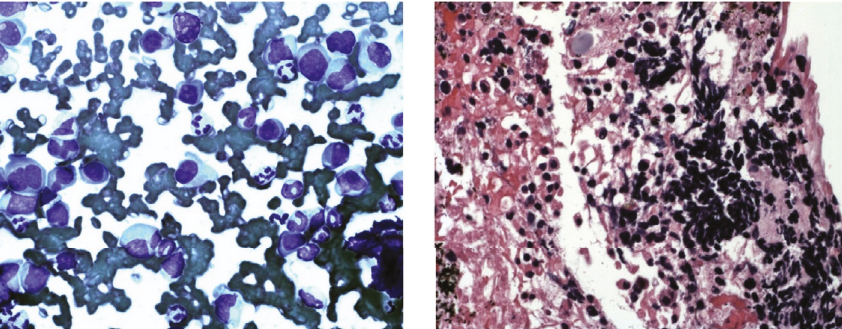
Figure 3: Cytology smear (Diff-Quick stain) of the FNA sample on the left showed numerous plasma cells with atypical nucleoli under 400x magnification. Hematoxylin and eosin staining of the FNA sample showed abundant lymphocytes under 400x